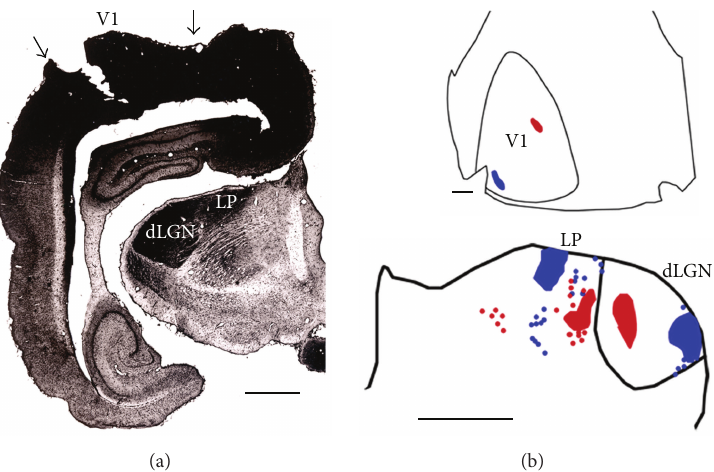
Figure 1: Cortical injections of HRP and fluorescent tracers. (a) Areas stained with HRP reaction product following multiple cortical injections of this enzyme. Arrows indicate borders of V1. The dLGN and LP are densely and homogeneously labeled by the transport of HRP (from case albino 86-21, Figure 5). Lateral is to the left and ventral is down. (b) Topographic retrograde labeling in dLGN and LP (lower panel) following injections of FB (blue) and red beads into V1 (upper panel) (from case albino 86-20, Figure 8). Lateral is to the right and ventral is down. dLGN: dorsal lateral geniculate nucleus, LP: lateroposterior nucleus of the thalamus. Sale bars = 2 mm.